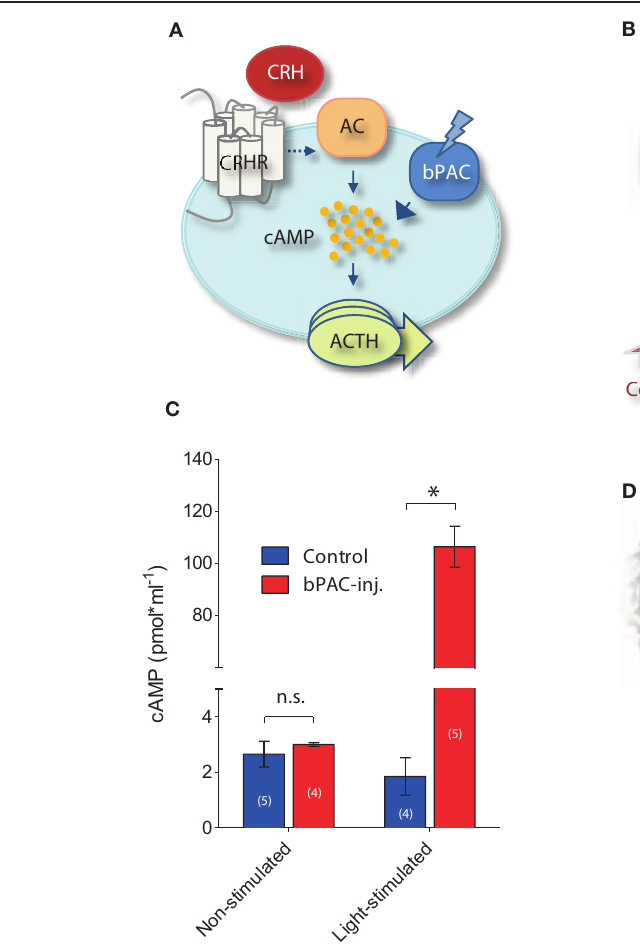
scheme, stress-induced over-elevation of cortisol would be varied by modifying the light-power and/or duration of the squared pulse of blue-light. (C) Blue-light dependent rise in whole-body cAMP level in 1dpf larvae using bPAC RNA (asterisks indicate statistical difference between groups at p < 0 . 05). (D) Dorsal and lateral views of bPAC expression in two cell clusters in the pituitary of 6 day post fertilization (dpf) larvae (scale bar: 500 µ m), as detected by fused tdTomato fluorescence; co-expression of ACTH and fluorescent tdTomato signal (top), and of myc-tag and tdTomato signal (bottom); scale bars: 50 µ